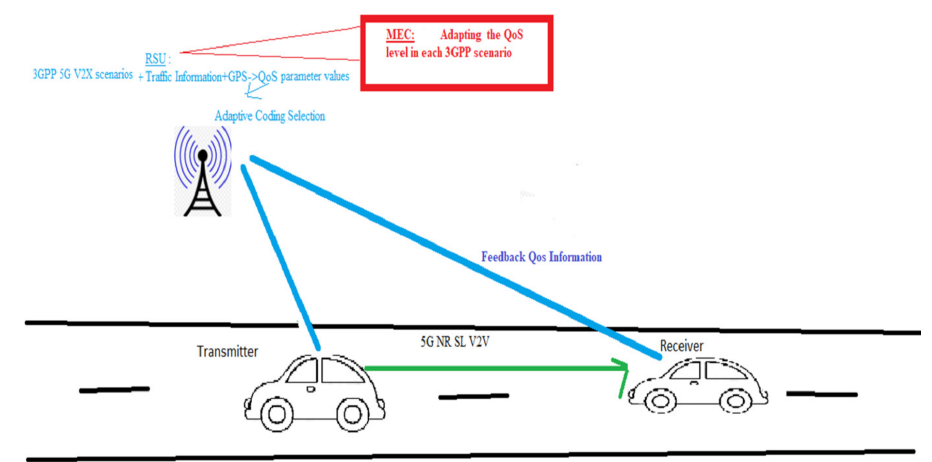
Figure 1. Proposed dynamic selection channel coding system